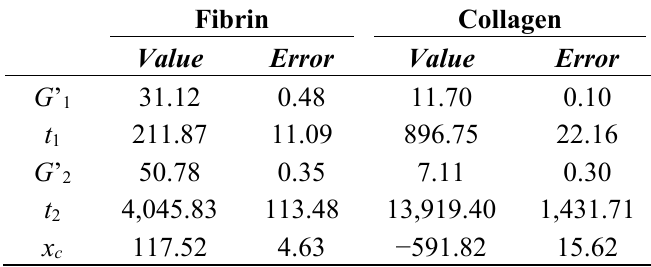
Table 3. Parameters used to fit Equation (3) to the measured data in Figure